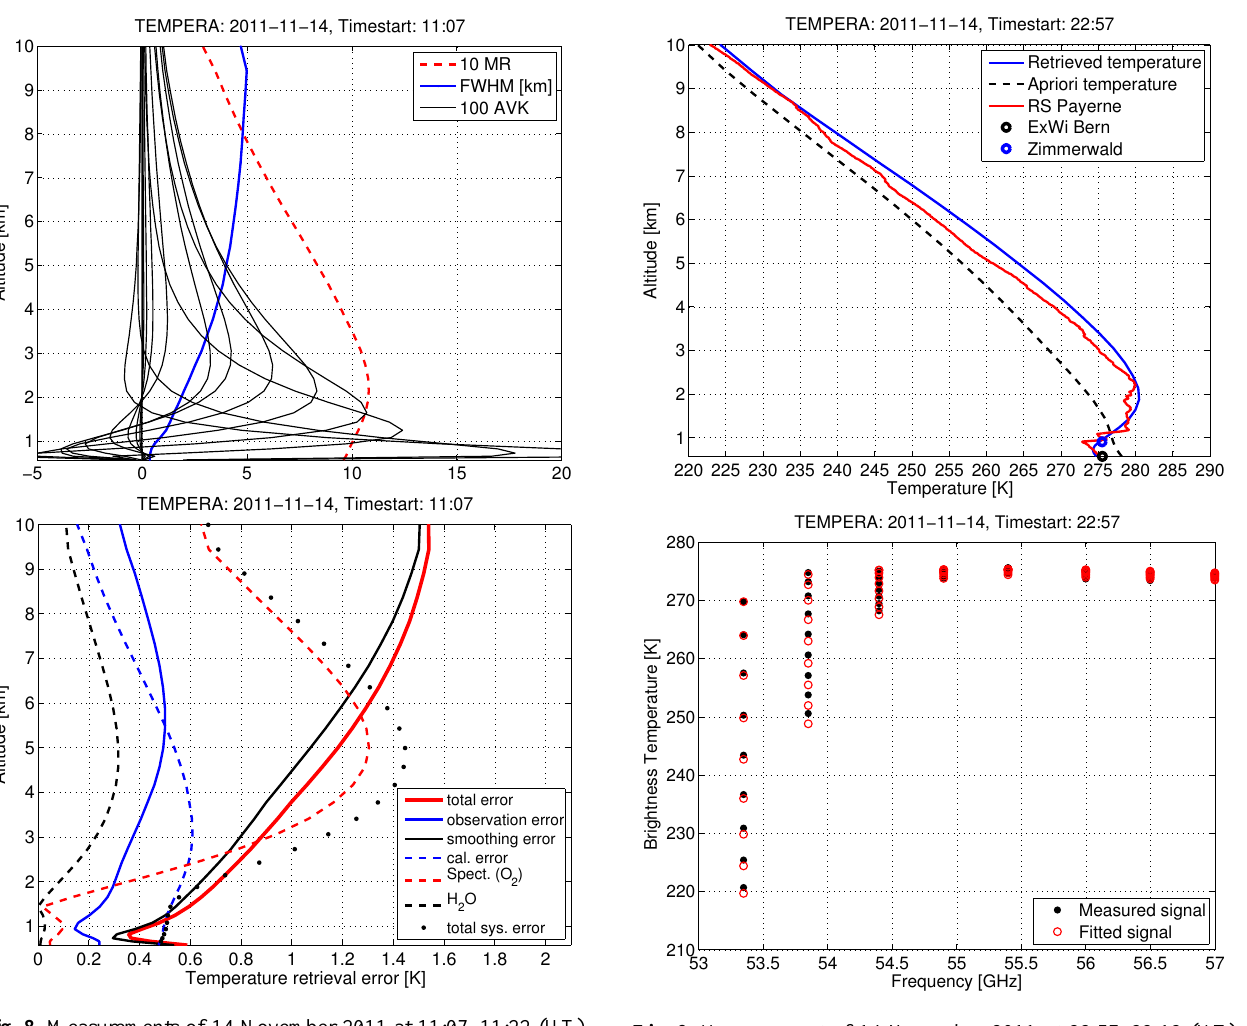
Fig. 8. Measurements of 14 November 2011 at 11:07–11:22 (UT) Fig. 9. Measurement of 14 November 2011 at 22:57–23:12 (UT) during clear sky (ILW=0mm). Upper panel: the averaging kernels during cloudy sky (ILW=0.1mm). Upper panel: temperature pro- Fig. 8. Measurements of November 14, 2011 at 11h07-11h22 (UT) during clear sky (ILW=0 mm). Upper (AVK, plotted every 4th) of TEMPERA are shown in this plot to- Fig. 9. Measurement of November 14, 2011 at 22h57-23h12 (UT) during cloudy sky (ILW=0.1 mm). file (blue line) retrieved with TEMPERA. The a priori profile is gether with the measurement response (MR) and the full-width at the dashed black line. The retrieved profile is compared with ra- panel: The averaging kernels (AVK, plotted every 4th) of TEMPERA are shown in this plot together with Upper panel: Temperature profile (blue line) retrieved with TEMPERA. The a-priori profile is the dashed half-maximum (FWHM, in km). Lower panel: error of the retrieval. diosonde data from Payerne (red line), with weather station data The error statistics contain the total error (solid red) consisting of from Bern (black circle), and with Zimmerwald (blue circle). Lower the measurement response (MR) and the full-width at half-maximum (FWHM, in km). Lower panel: Error black line. The retrieved profile is compared with radiosonde data from Payerne (red line) and with observation error (solid blue) and smoothing error (solid black). The panel: brightness temperatures of 8 channels measured with TEM- total systematic error (dotted black) contains the uncertainties in the of the retrieval. The error statistics contain the total error (solid red) consisting of observation error (solid PERA (black) compared with the forward model brightness temper- weather station data from Bern (black circle), Zimmerwald (blue circle). Lower panel: Brightness tem- calibration (dashed blue), in the oxygen profile (“spectroscopic er- atures (red) corresponding to the blue) and smoothing error (solid black). The total systematic error (dotted black) contains the uncertainties peratures of 8 channels measured with TEMPERA (black) compared with the forward model brightness ror”, dashed red) and in the water vapor profile (dashed black). in the calibration (dashed blue), in the oxygen profile (”spectroscopic error”, dashed red) and in the water temperatures (red) corresponding to the retrieval. vapor profile (dashed black).